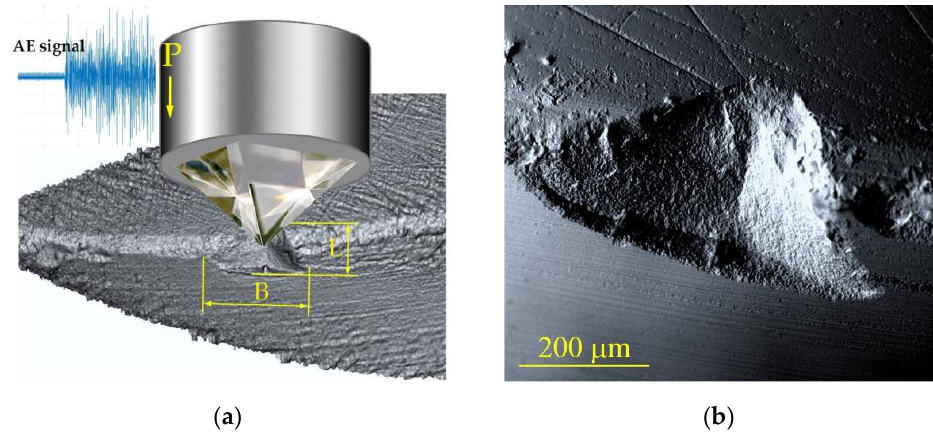
Figure 4. Schematic diagram of the method used to evaluate the resistance of the CCI cutting edges to chipping: ( a ) the impact of the destructive load created by the diamond indenter near the cutting edge; ( b ) SEM-image of the chipping area of the cutting